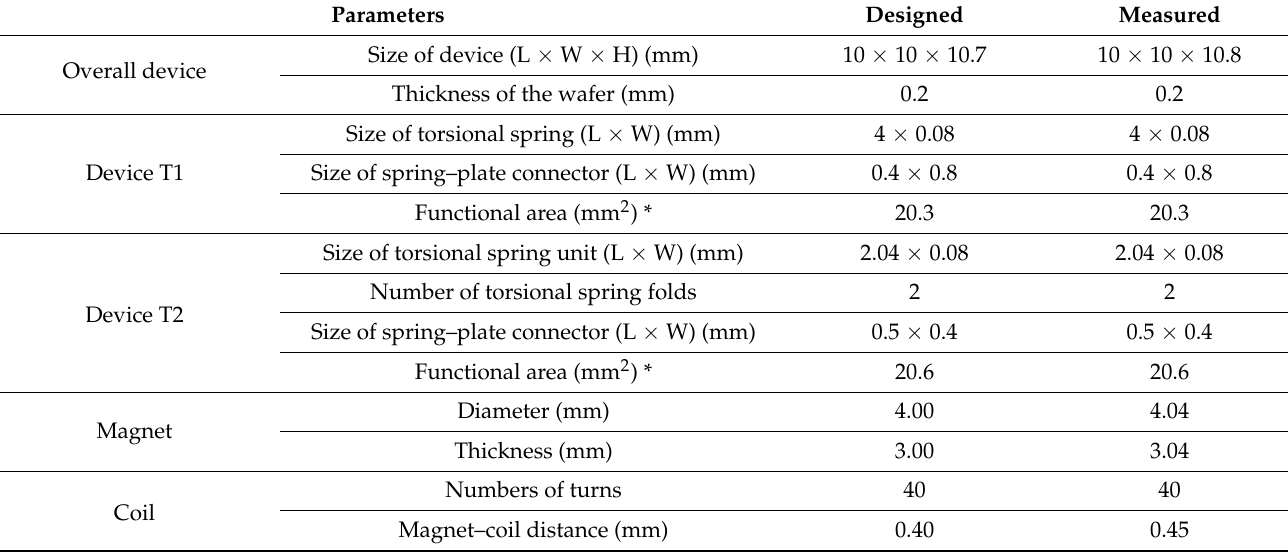
Figure 1. Schematic and exploded illustration of the assembled EVEH. ( a ) schematic illustration of the EVEH device; ( b ) exploded view of the EVEH device; ( c ) two types of torsional spring; ( d ) a layer of flexible coils. Table 1. Main design parameters of the EVEH device.